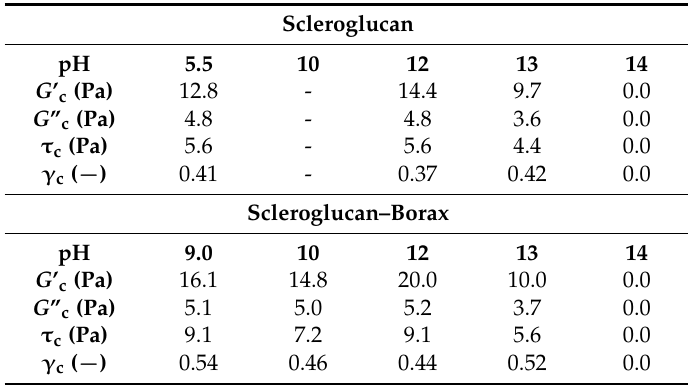
Table 1. Linear viscoelastic threshold for the Sclg and Sclg–borax systems (cp = 0.7%). G ’ c and G ” c are the critical storage and the loss moduli; τ c and γ c are the critical stress and the critical deformation,